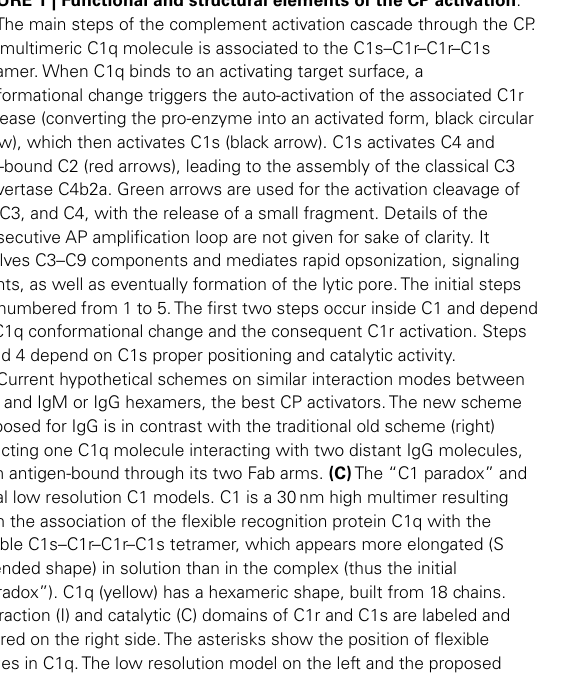
FIGURE 1 | Functional and structural elements of the CP activation . (A) The main steps of the complement activation cascade through the CP. The multimeric C1q molecule is associated to the C1s–C1r–C1r–C1s tetramer.When C1q binds to an activating target surface, a conformational change triggers the auto-activation of the associated C1r protease (converting the pro-enzyme into an activated form, black circular arrow), which then activates C1s (black arrow). C1s activates C4 and C4b-bound C2 (red arrows), leading to the assembly of the classical C3 convertase C4b2a. Green arrows are used for the activation cleavage of C2, C3, and C4, with the release of a small fragment. Details of the consecutive AP amplification loop are not given for sake of clarity. It involves C3–C9 components and mediates rapid opsonization, signaling events, as well as eventually formation of the lytic pore.The initial steps are numbered from 1 to 5.The first two steps occur inside C1 and depend on C1q conformational change and the consequent C1r activation. Steps 3 and 4 depend on C1s proper positioning and catalytic activity. (B) Current hypothetical schemes on similar interaction modes between C1q and IgM or IgG hexamers, the best CP activators.The new scheme proposed for IgG is in contrast with the traditional old scheme (right) depicting one C1q molecule interacting with two distant IgG molecules, each antigen-bound through its two Fab arms. (C) The “C1 paradox” and initial low resolution C1 models. C1 is a 30nm high multimer resulting from the association of the flexible recognition protein C1q with the flexible C1s–C1r–C1r–C1s tetramer, which appears more elongated (S extended shape) in solution than in the complex (thus the initial “paradox”). C1q (yellow) has a hexameric shape, built from 18 chains. Interaction (I) and catalytic (C) domains of C1r and C1s are labeled and colored on the right side.The asterisks show the position of flexible hinges in C1q.The low resolution model on the left and the proposed